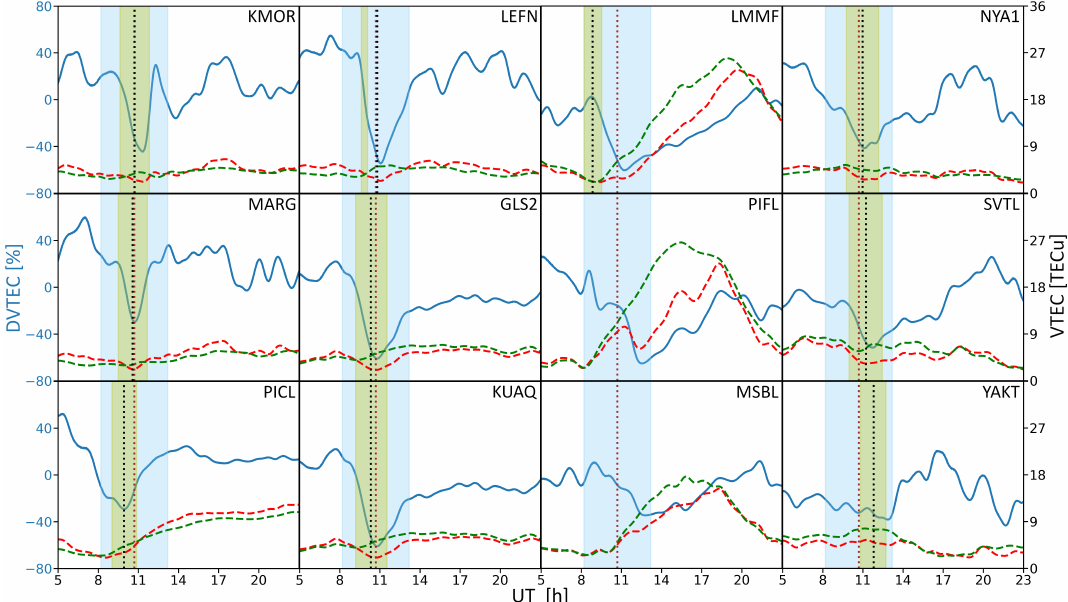
Figure 8. The behavior of the ionospheric TEC during the 10 June 2021 Annular Solar Eclipse in 12 of the 24 selected GNSS stations. DVTEC[%] (blue line), VTECe (red dashed line) and VTEC (green dashed line). The GNSS stations are ordered by latitude and then by longitude. P1–P4 time is represented by the light blue bar, C1–C4 time by the yellow bar, MOT by black dotted line, and GE time by the red dotted